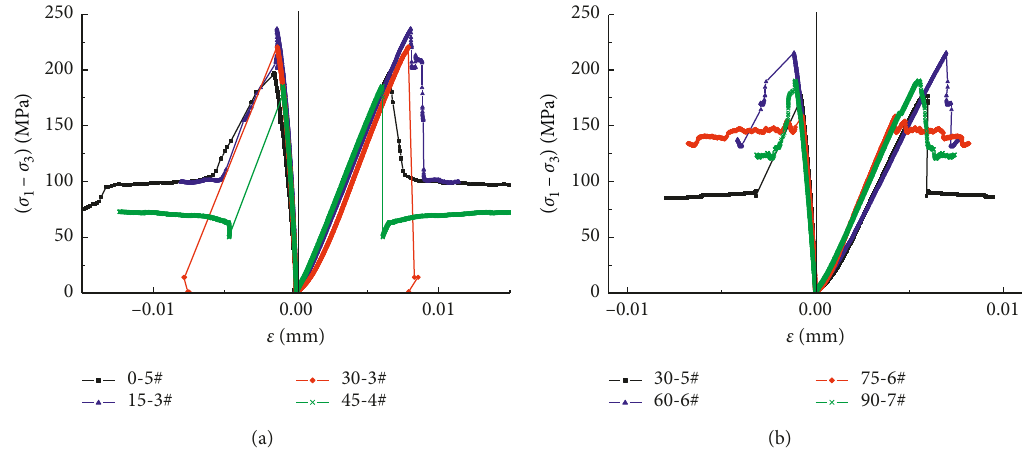
Figure 8: The stress-strain curves of the specimens: confining pressure of